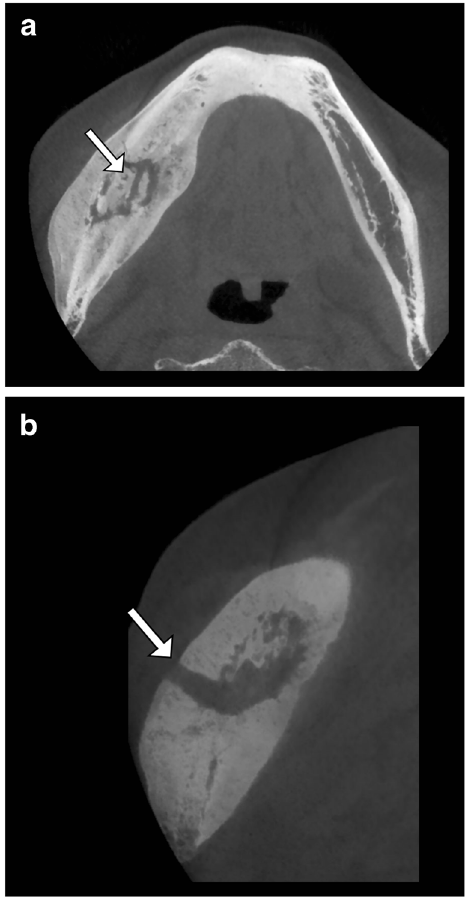
Fig. 7 Chronic osteomyelitis of the right hemimandible. a . Axial CBCT reformatted image showing chronic osteomyelitis of the right hemimandible with intralesional sequestrum (arrow). Note marked sclerosis of the right hemimandible compared to the left side and massive periosteal bone reaction (involucrum). b . Detailed axial view shows the course of a fistula through the mandibular cortex to the buccal soft tissues